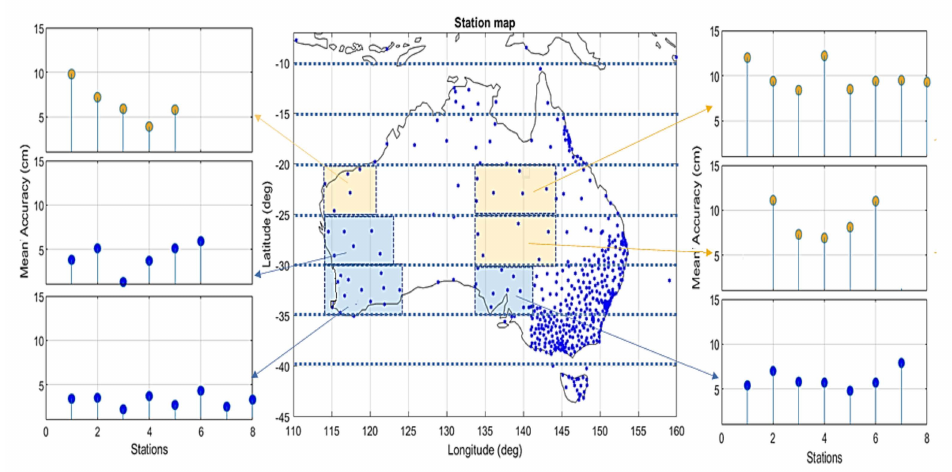
Figure 10. Evaluation of the accuracy of the ionospheric corrections in the test regions of South Australia (SA), Western Australia (WA) and Central Australia. The blue and orange boxes show the testing regions where the mean accuracy achieved is below 8 cm and up to 15 cm, respectively. The arrows link from the testing stations to the corresponding figures of mean accuracy of each station in the test region.